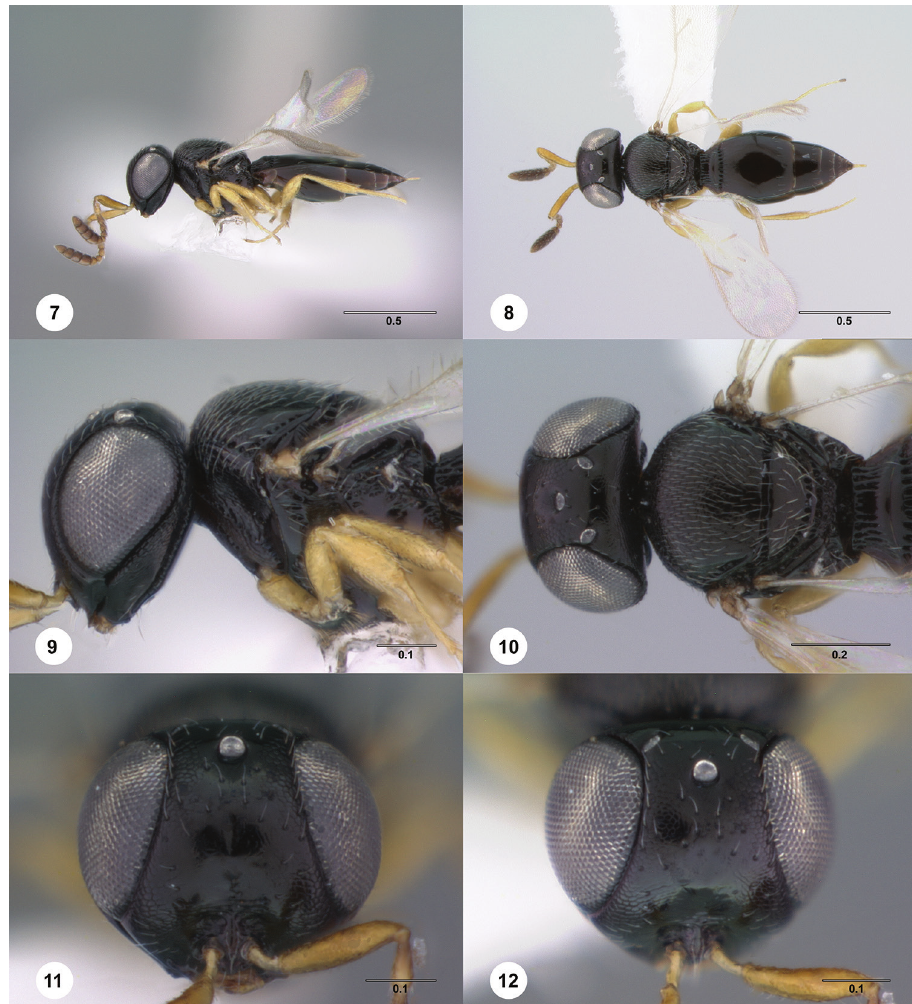
Figures 7–12. Phanuromyia constellata ♀ (OSUC 322906), 7 Lateral habitus 8 Dorsal habitus 9 Head, mesosoma, lateral view 10 Head, mesosoma, dorsal view 11 Head, mouthparts, anteroventral view 12 Head, ventral view. Scale bar in millimeters. T1: swollen in posterior half. Anterior margin of T2: with costae or foveolae throughout its width. T2 sculpture: with neither transverse series of small punc- tures nor scrobiculate lateral areas. Sculpture of T1: entirely costate. Posterior margin of T2: straight; only slightly concave. Number of visible terga past T2: 4 or 5. Setation on T2: limited to at most 1 row of setae posteriorly and sparse setation